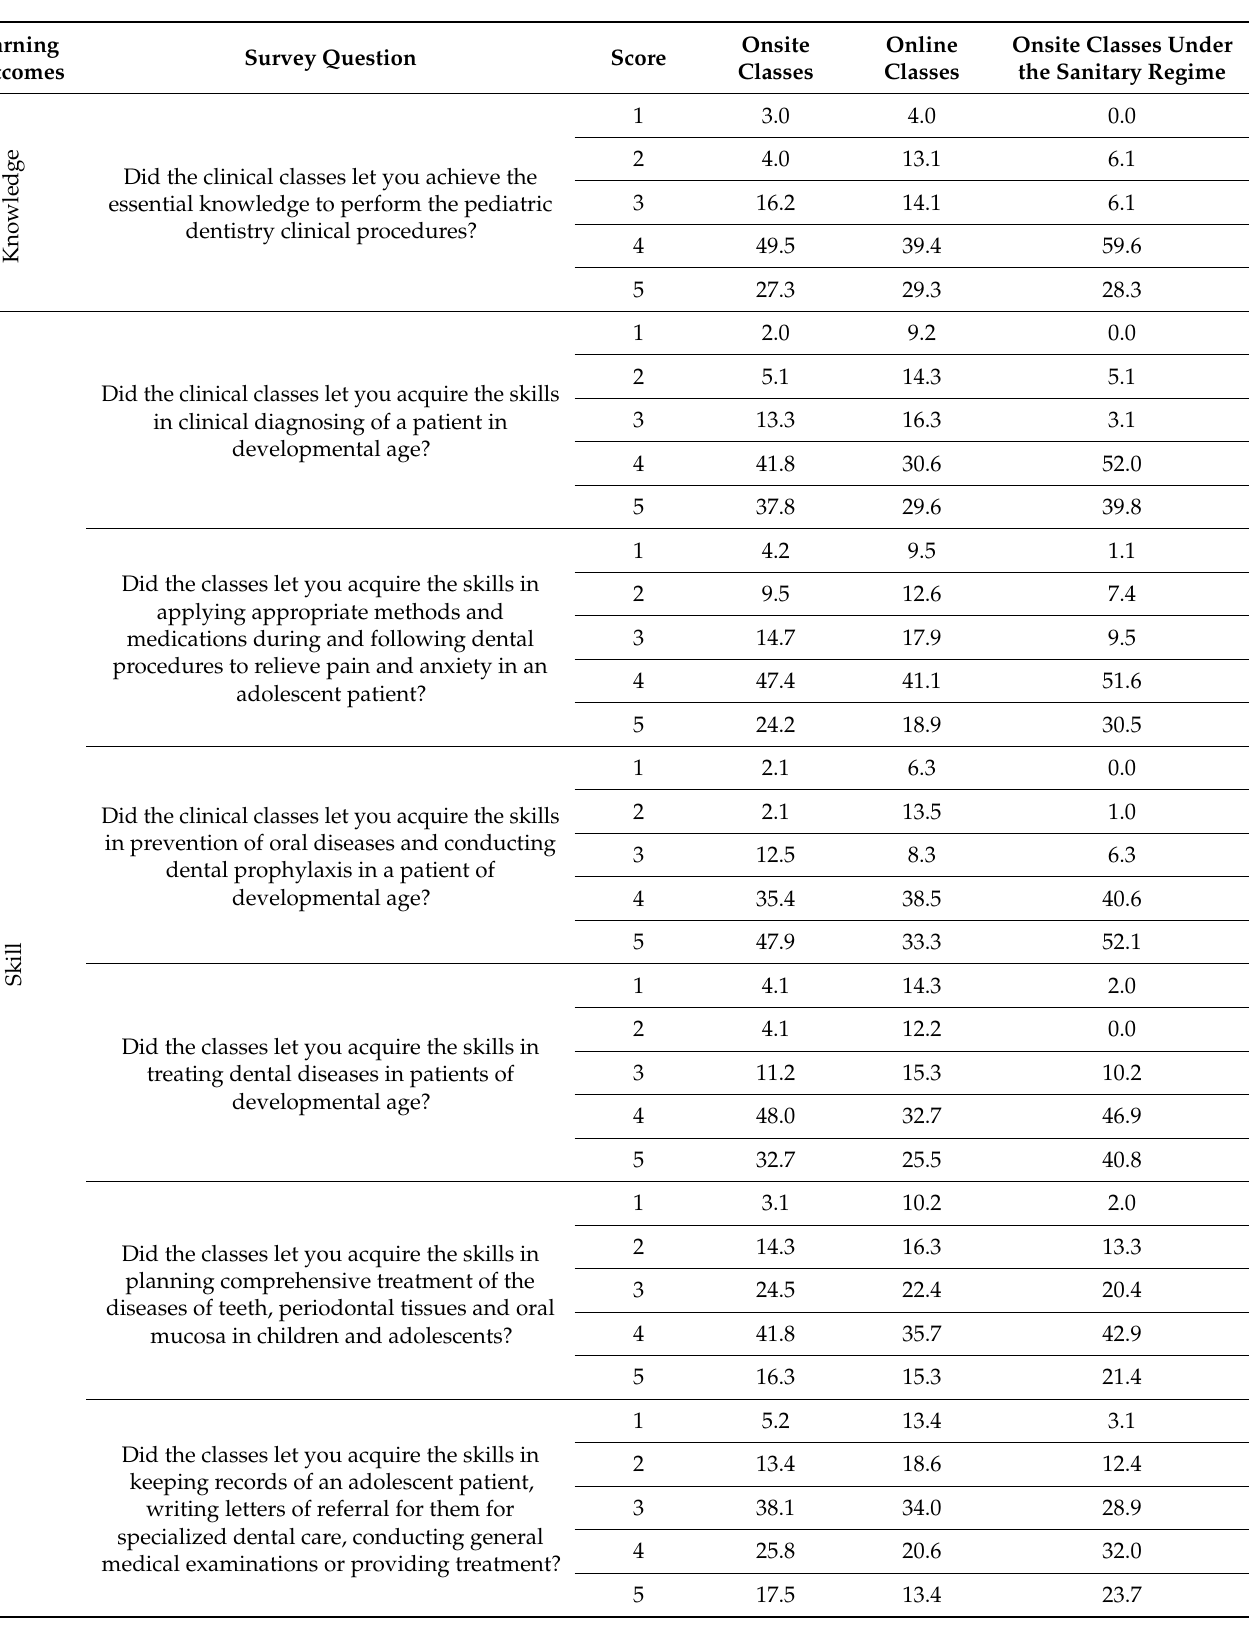
Table 1. Percentage of students choosing a particular answer for a specific question